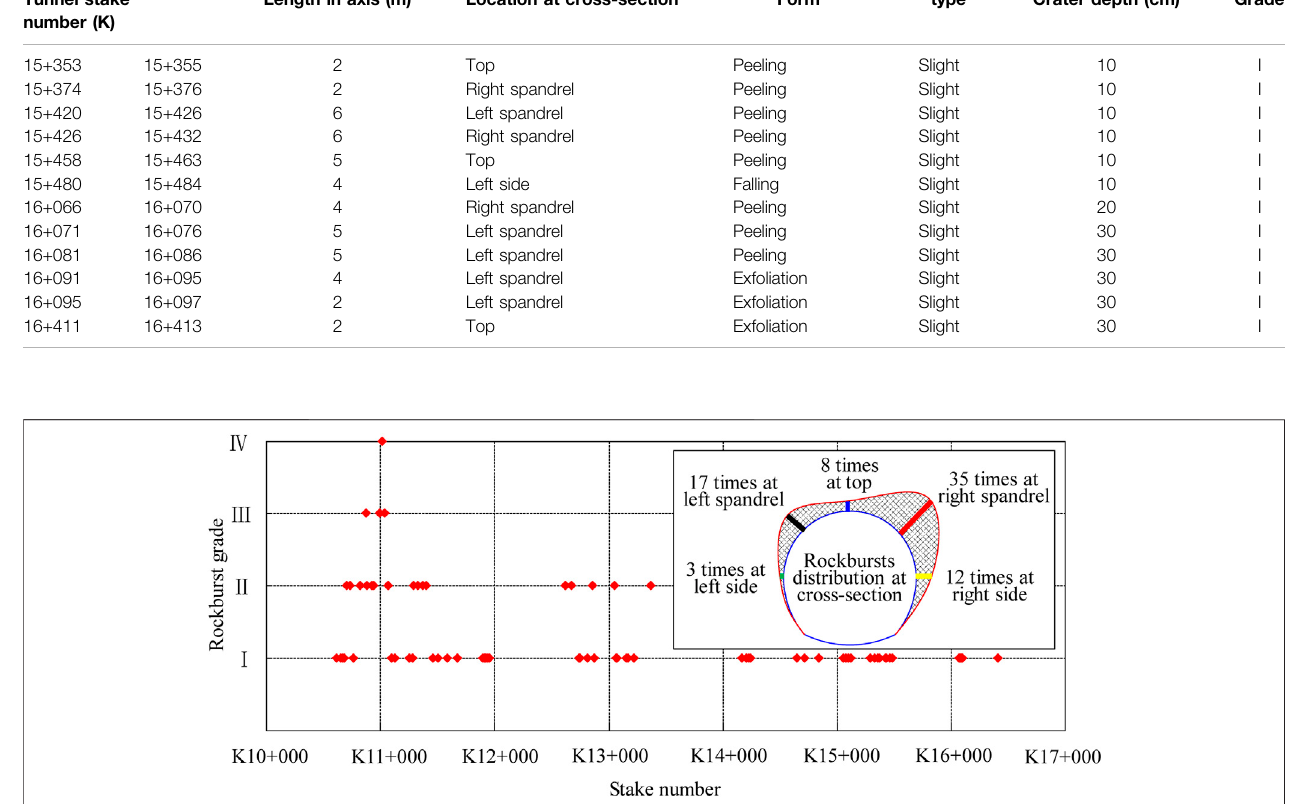
FIGURE 3 | Rockburst grade along the tunnel axis and rockburst frequency at the tunnel cross-section.